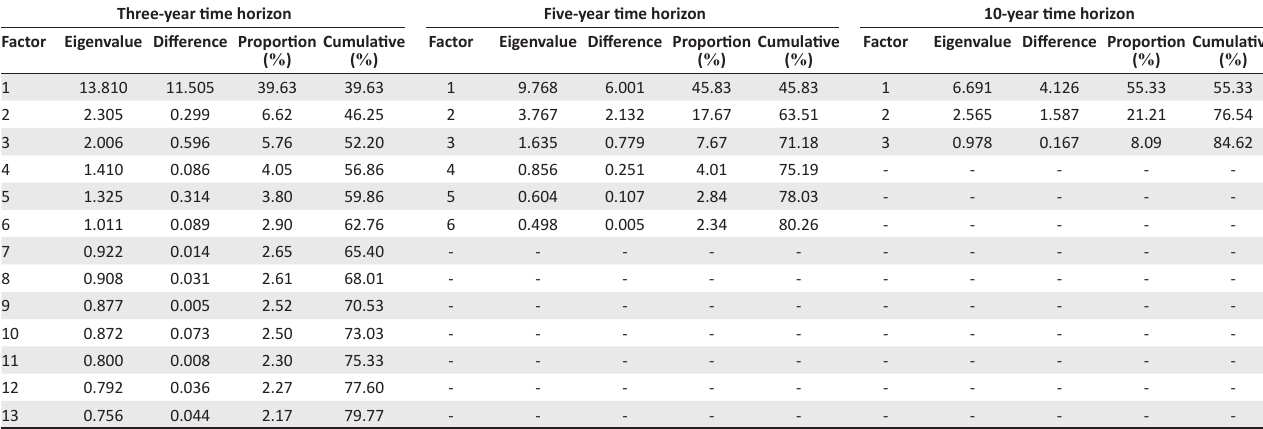
TABLE 1: Factor eigenvalues (varimax rotation). Three-year time